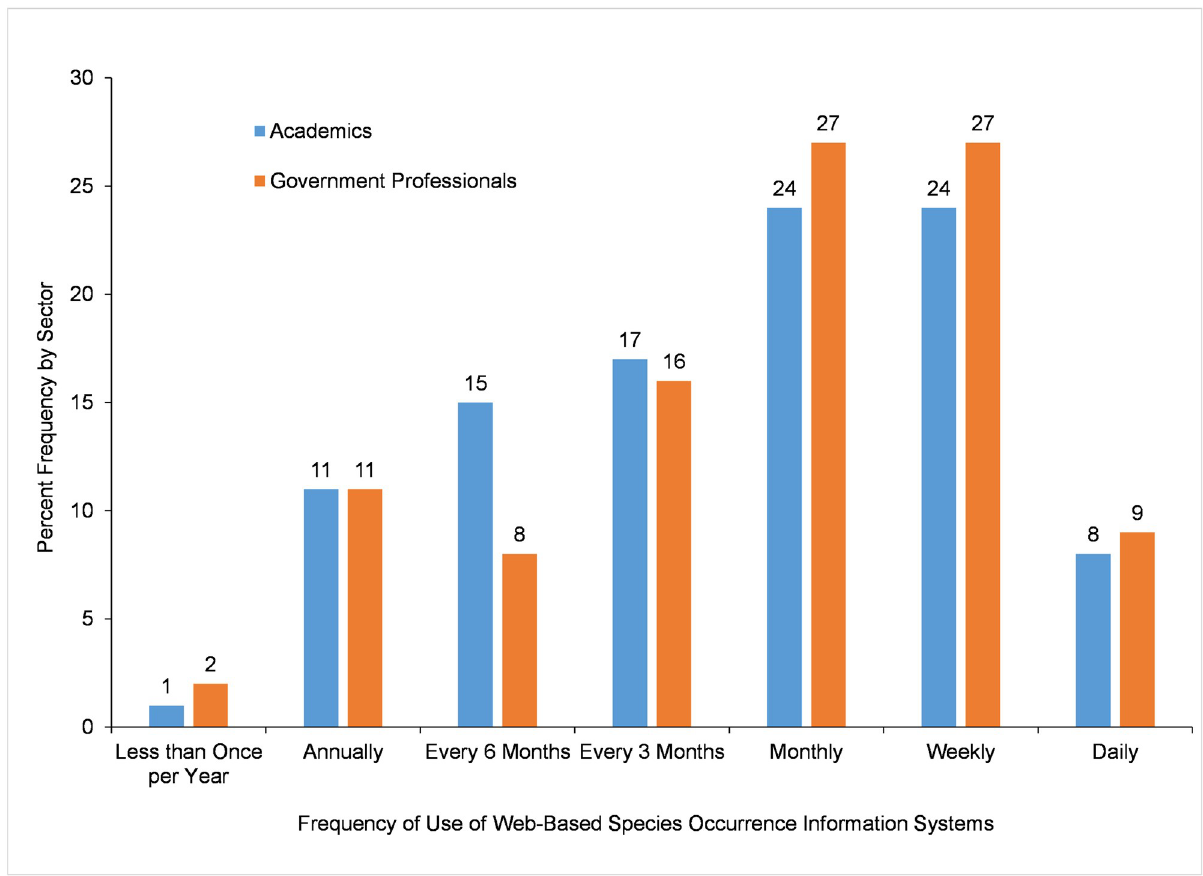
Fig 6. Frequency of use of web-based species occurrence information systems by participants who reported using those systems in the past 12 months.